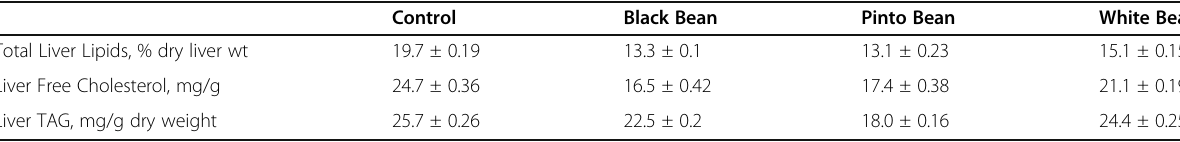
Table 3 Plasma and Liver Cholesterol and Triglycerides